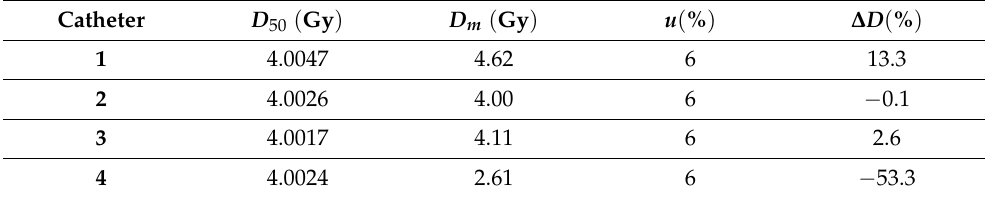
Table 8. D m compared to TPS calculated dose D 50 for the 3 mm slice thickness plan with four active dwell positions. The relative standard uncertainty u ( % ) with k = 2 is also shown along with percent differences between planned and measured